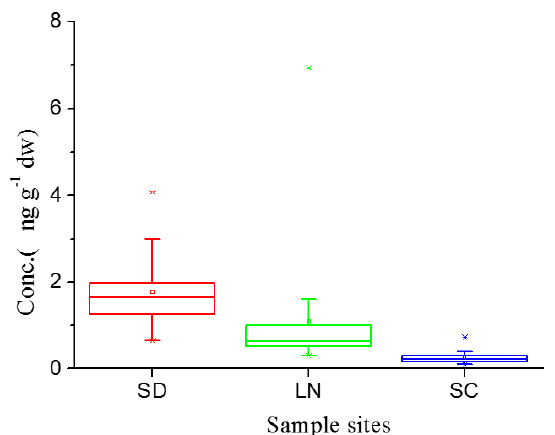
Figure 2. The box plot of concentration of ∑ PFAAs in soil samples from Shandong (SD), Liaoning (LN), and Sichuan (SC) province. “ □ ” represents 25%–75%, “ * ” represents the outliers, “ Ⅰ ”represents Min–Max.